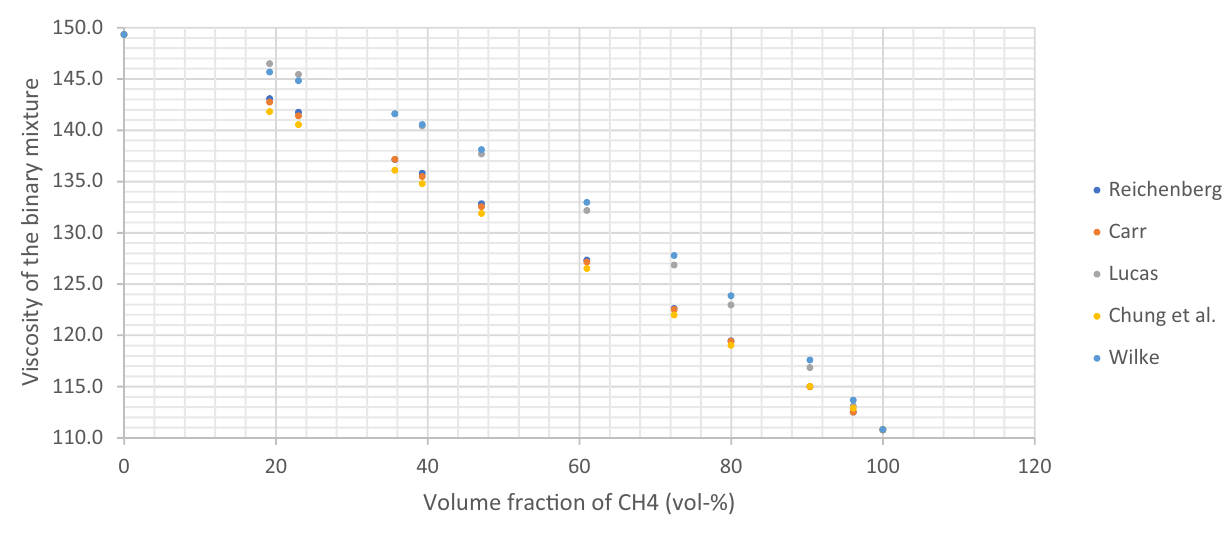
Figure 2. Viscosity of the binary gas mixtures from Table 1 calculated using five different